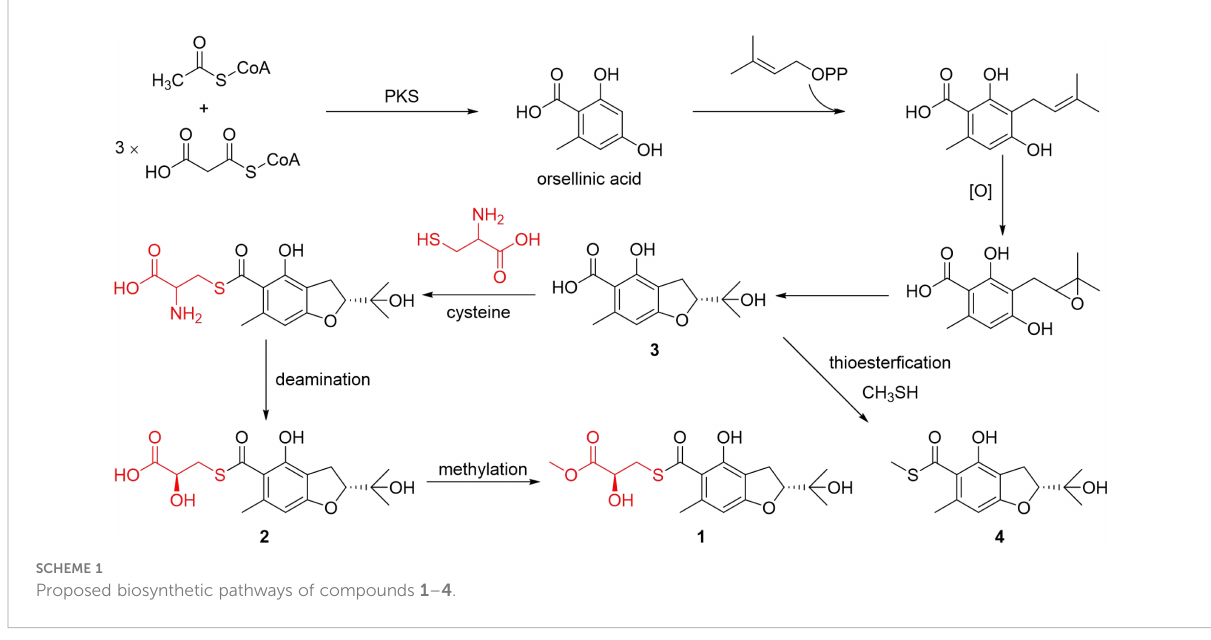
SCHEME 1 Proposed biosynthetic pathways of compounds 1 – 4 .